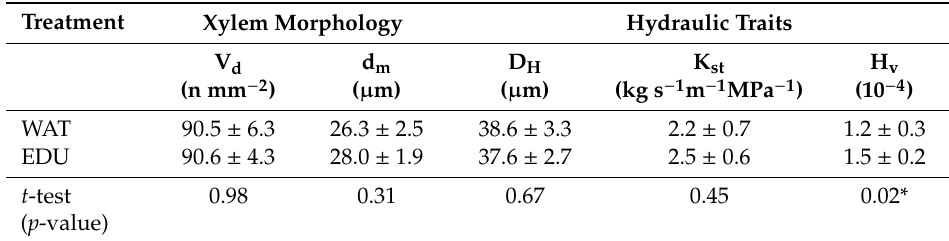
Table 2. Mean values ( ± SD) of xylem morphology and hydraulic traits in WAT (water treated) and EDU (EDU treated) trees. V d : vessel density, d m : average vessel diameters, D H : hydraulic diameter, K st : theorical hydraulic conductivity, H V : Huber value.